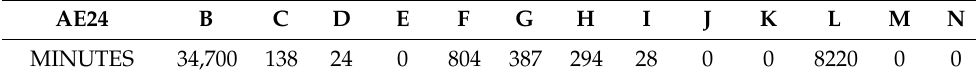
Table 9. Minutes in each of the states of a wind